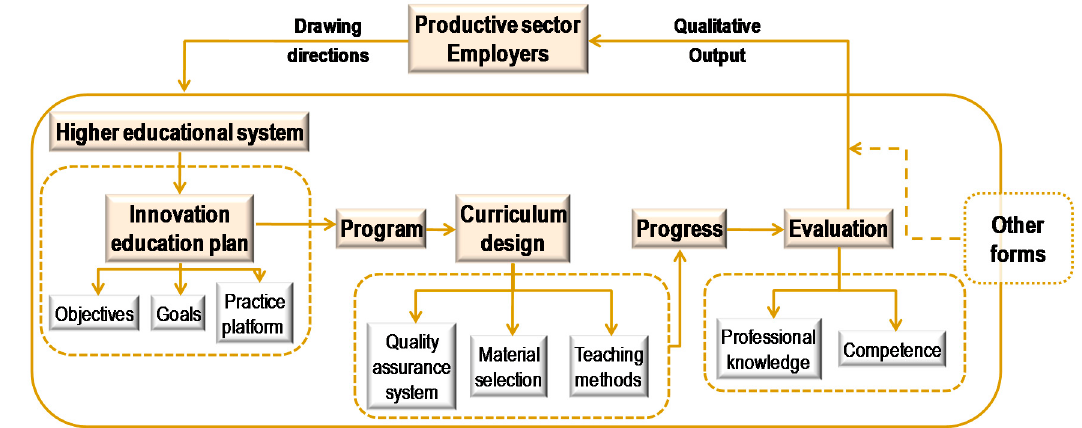
Figure 1. The relationship diagram between higher education system tasks and employers from various